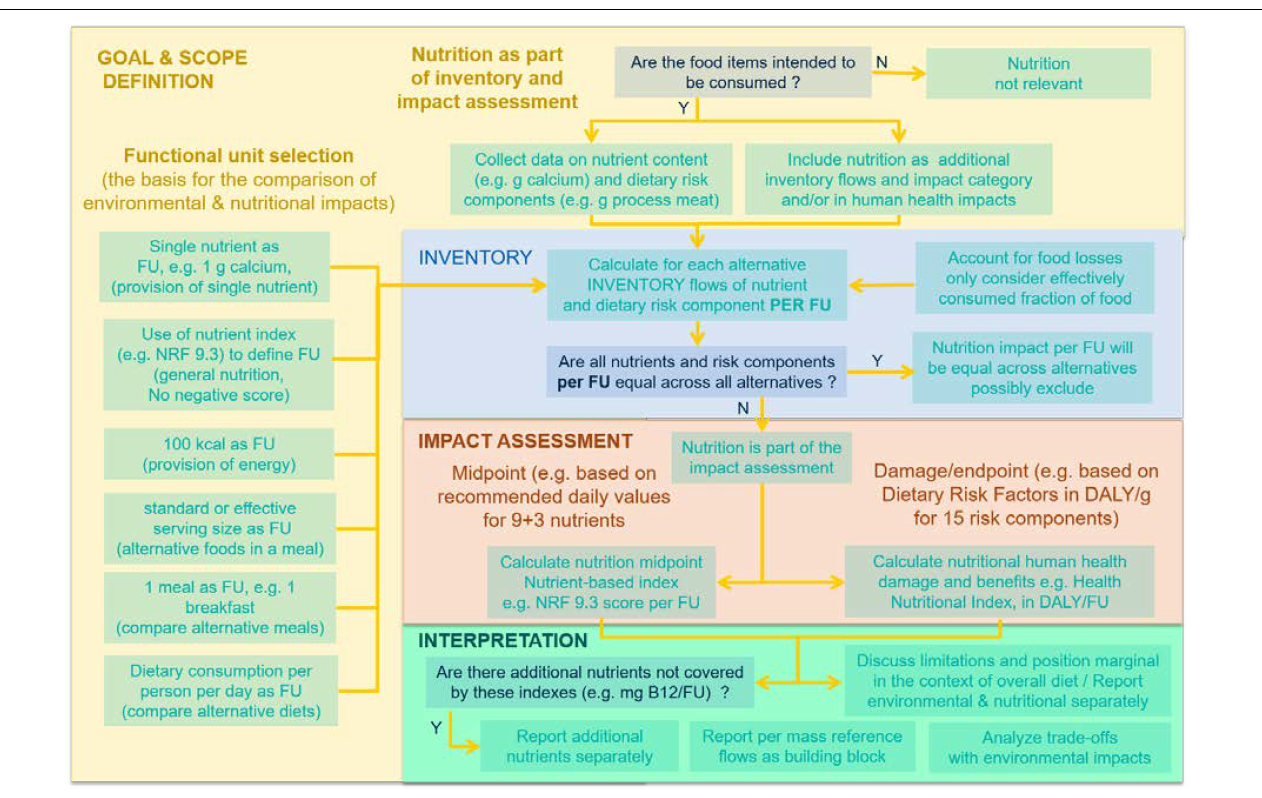
FIGURE 2 | Integration of the nutrition impact associated with food consumption during use stage, in the life cycle assessment of foods or food